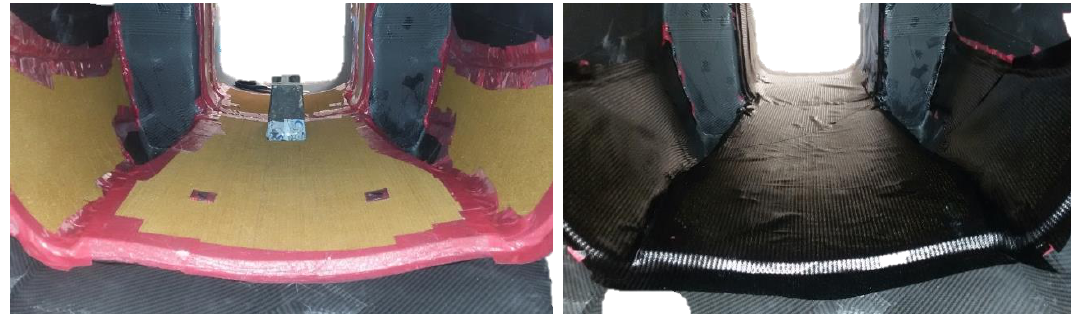
Figure 13. Second lamination in the central part: Nomex honeycomb ( left ) and composite layers ( right ) .